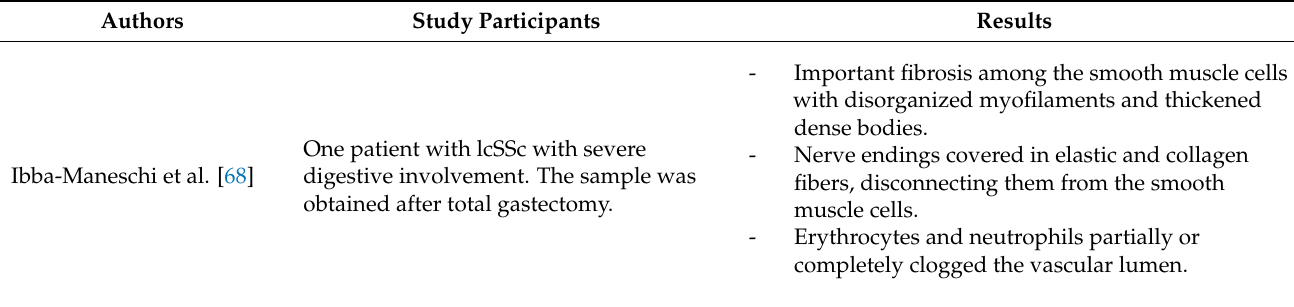
Table 1. Histological aspects of the gastric wall in systemic